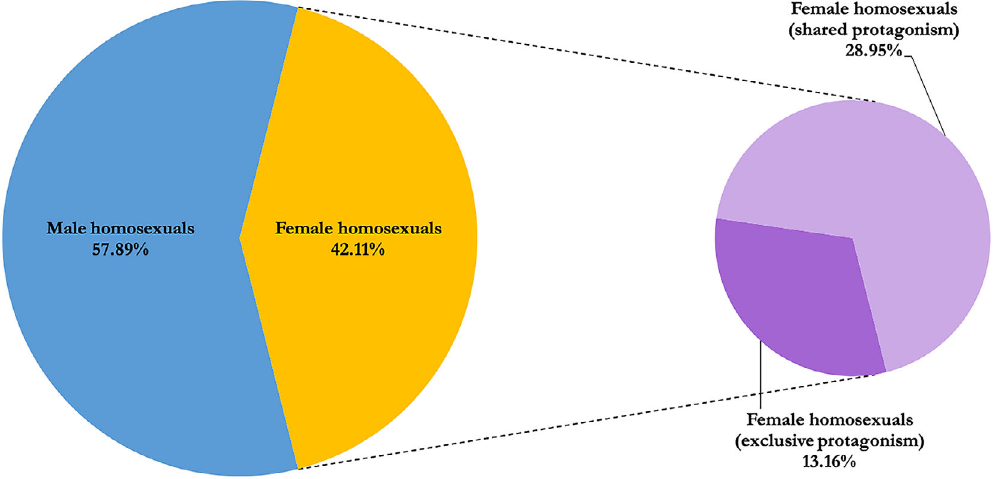
Figure 5. Representation of gay men and lesbian ´ couples. Source: Own